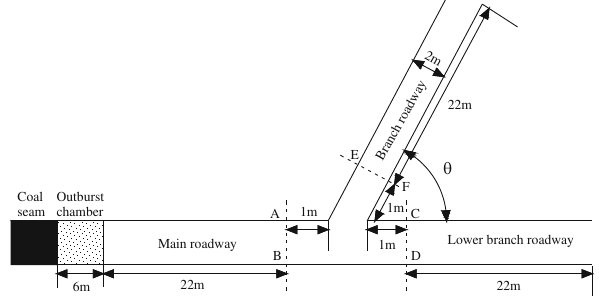
Fig. 8 Geometry of bifurcating roadway